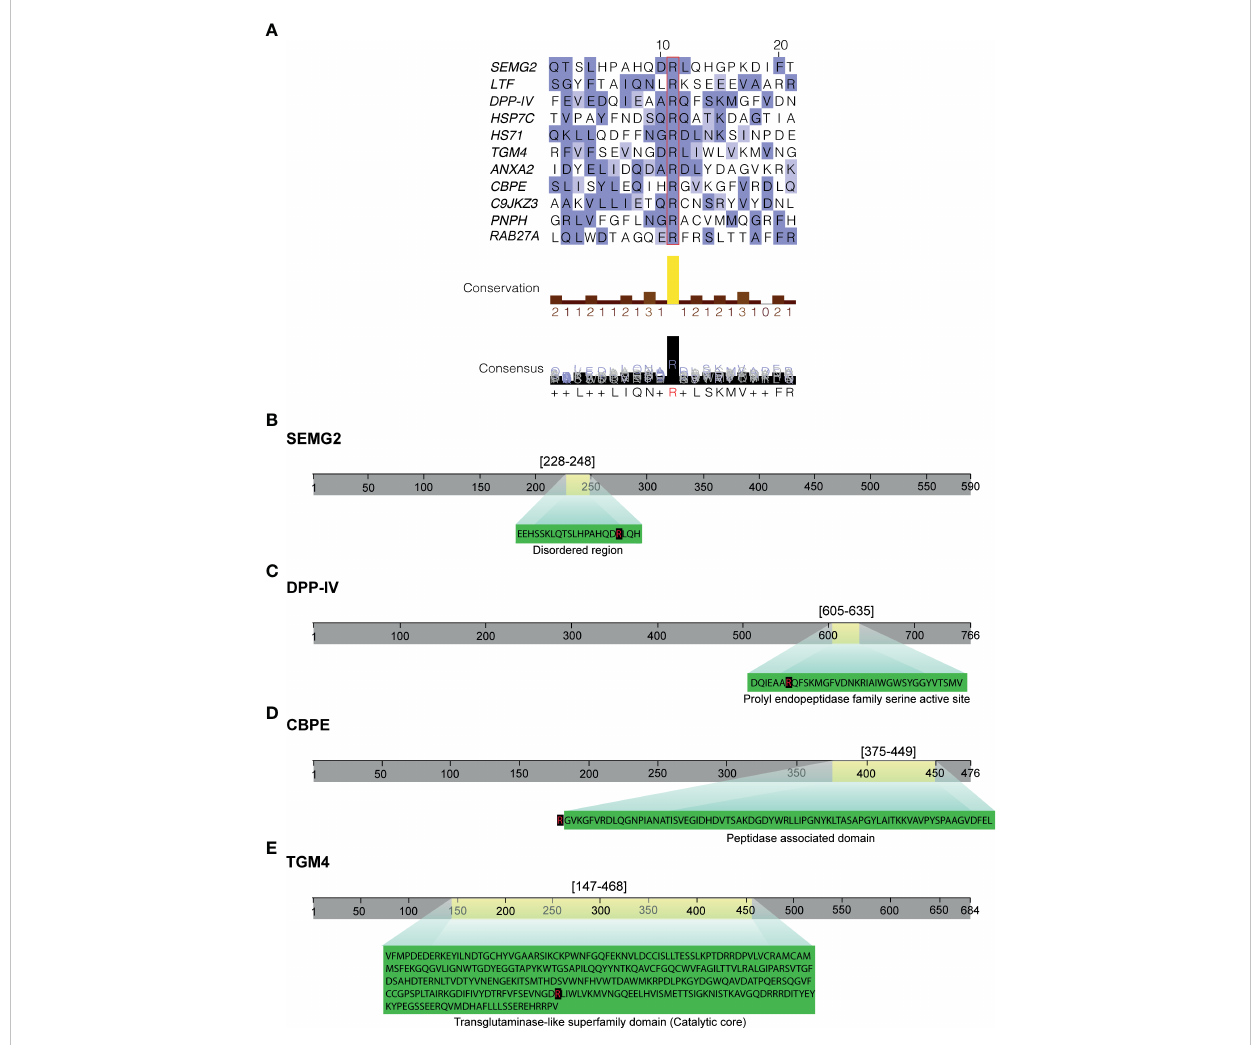
FIGURE 3 Functional bioinformatics of citrullinated (Cit) proteins in sEV proteomes of non-normozoospermic (non-NZ) men compared to healthy controls (NZ). Only Cit proteins that were signi fi cantly modulated in non-NZ compared to NZ (p ≤ 0.05) were considered for these analyses. (A) Multiple sequence alignment (Blosum 62) of Cit proteins in sEV proteomes signi fi cantly modulated in non-NZ compared to NZ, performed with Jalview. Sequence alignment was performed with partial sequences that formed Cit Arg (squared in red) ± 10 residues. Conserved residues are highlighted in blue shades (mid blue: >60% agreement, light blue: >40% agreement). The amino acid position numbers shown at the top of the sequences correspond to the relative position in the aligned polypeptide. The conservation histogram displayed below the sequence alignment graphic re fl ects the conservation of physicochemical properties. The yellow column indicates the absolute conservation of Cit Arg (score 11), and less-conserved positions are shown in brown with a decreasing score. The consensus histogram shows the percentage of modal residue per position and includes the conserved sequence logo. “ + ” indicates non-conserved residues. (B – E) Predicting domain analysis performed using the Interpro database to de fi ne potential (dis)functional localizations of Cit Arg. Only proteins with relevant colocalizations between Cit Arg and predicted domains are displayed. Grey lines represent the entire sequence length of the protein. Light yellow areas represent the localization of the predicted domains within the entire protein sequence. Green magni fi cations contain the predicted domain sequence, and the Cit Arg is indicated in red and shaded in